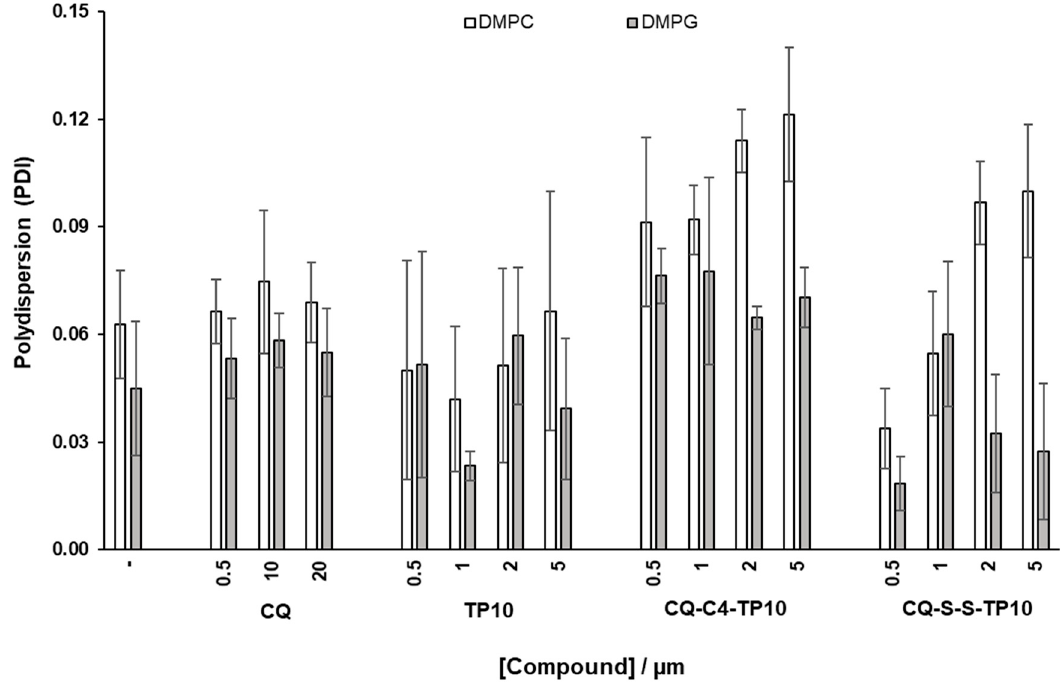
Figure 5. Effects of incubation with increasing concentrations of the test compounds on (polydispersion) PDI of DMPC and DMPG liposomes, taken as simplistic models of niRBC and PiRBC, respectively.